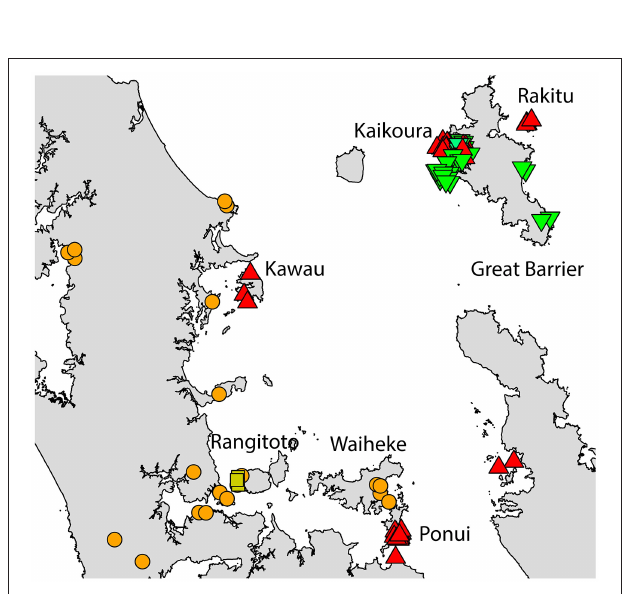
FIGURE 5 | The distribution of R. rattus haplotypes across the Hauraki Gulf, Auckland. = RatHap01, = RatHap02, = RatHap04, RatHap05 & RatHap06, = RatHap17.